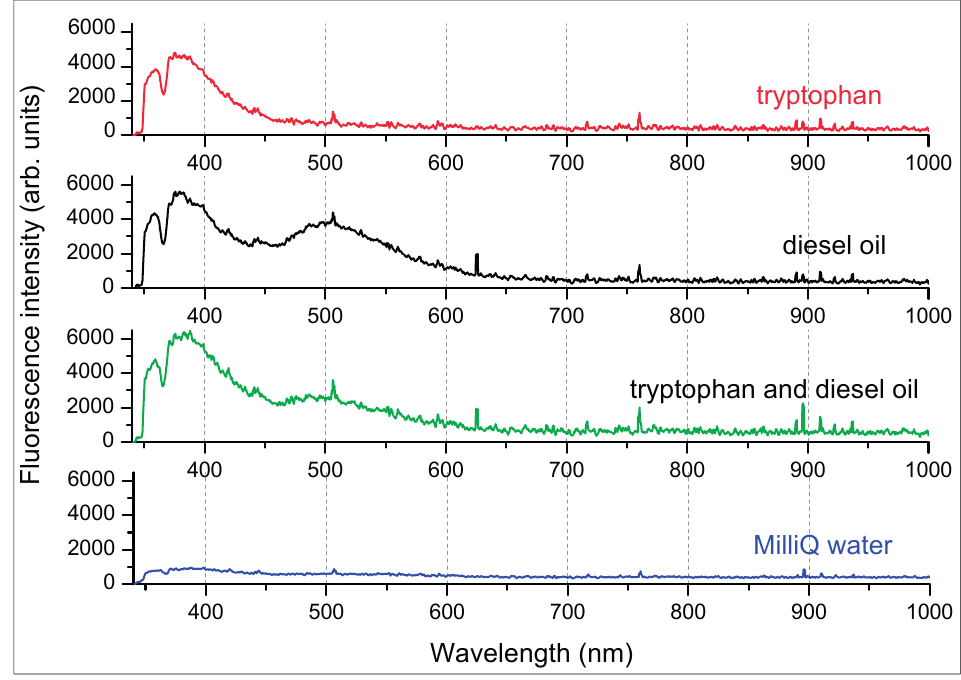
Figure 16. Diesel oil, tryptophan and Milli-Q water fluorescence spectra measured upon excitation at 280